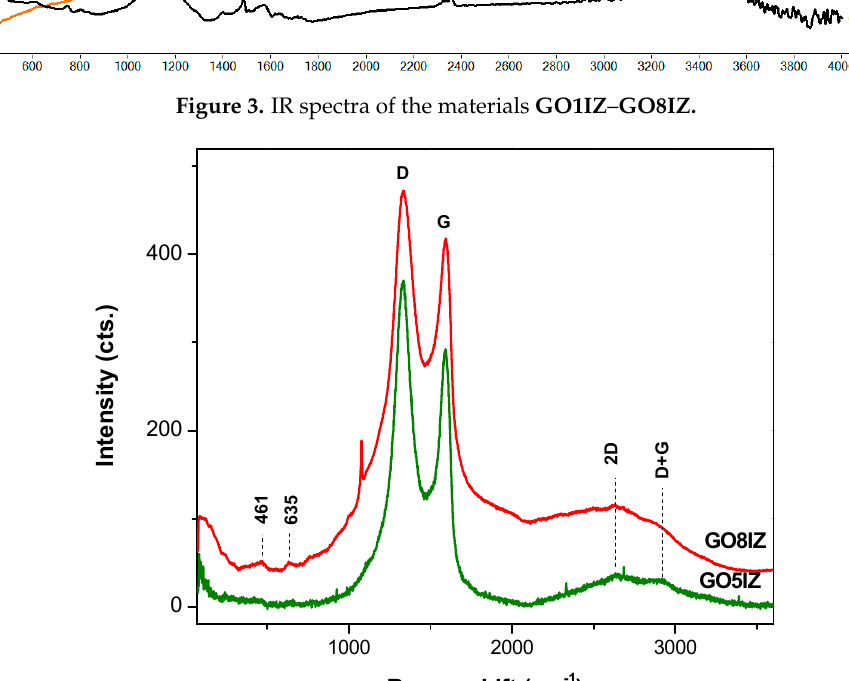
Figure 4. Raman spectra of the functionalized graphene oxides ( GO5IZ and GO8IZ samples).